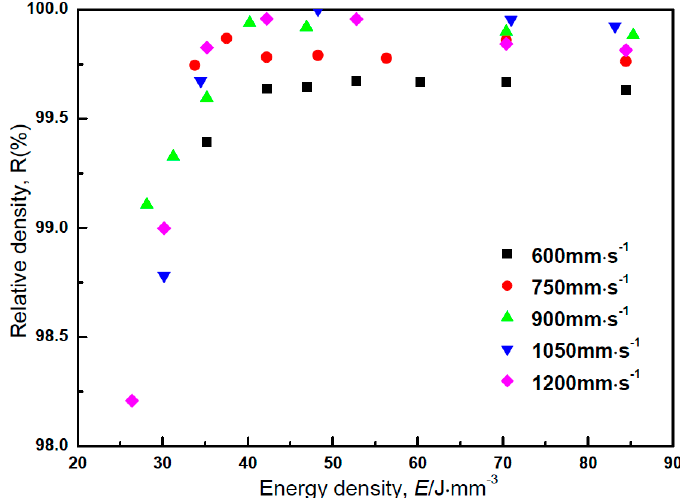
Figure 3. The relative density of the as-built Zr-1Mo alloys as a function of energy density.